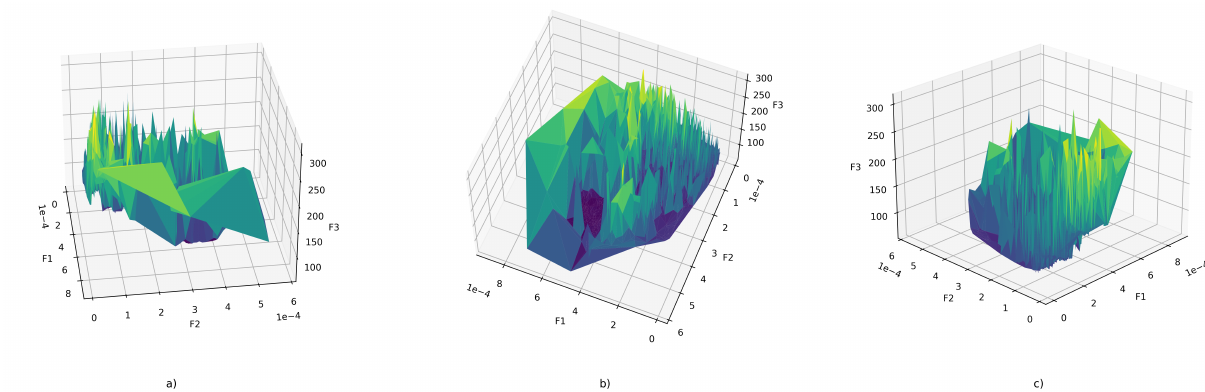
Figure 6. The plots ( a – c ) depict the shape of the optimized F 1 , F 2 , and F 3 objectives, ( a – c ) images plots the 3D surface of the objective function from different